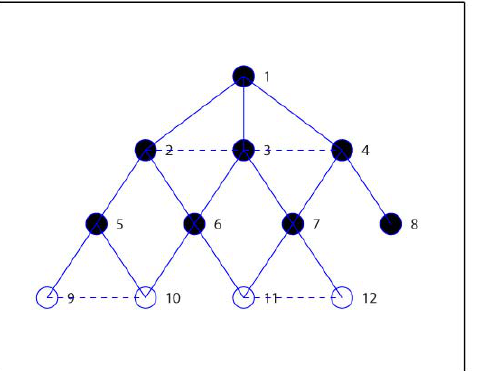
Figure 5. CDS construction for the given example in EMCDS algorithm.